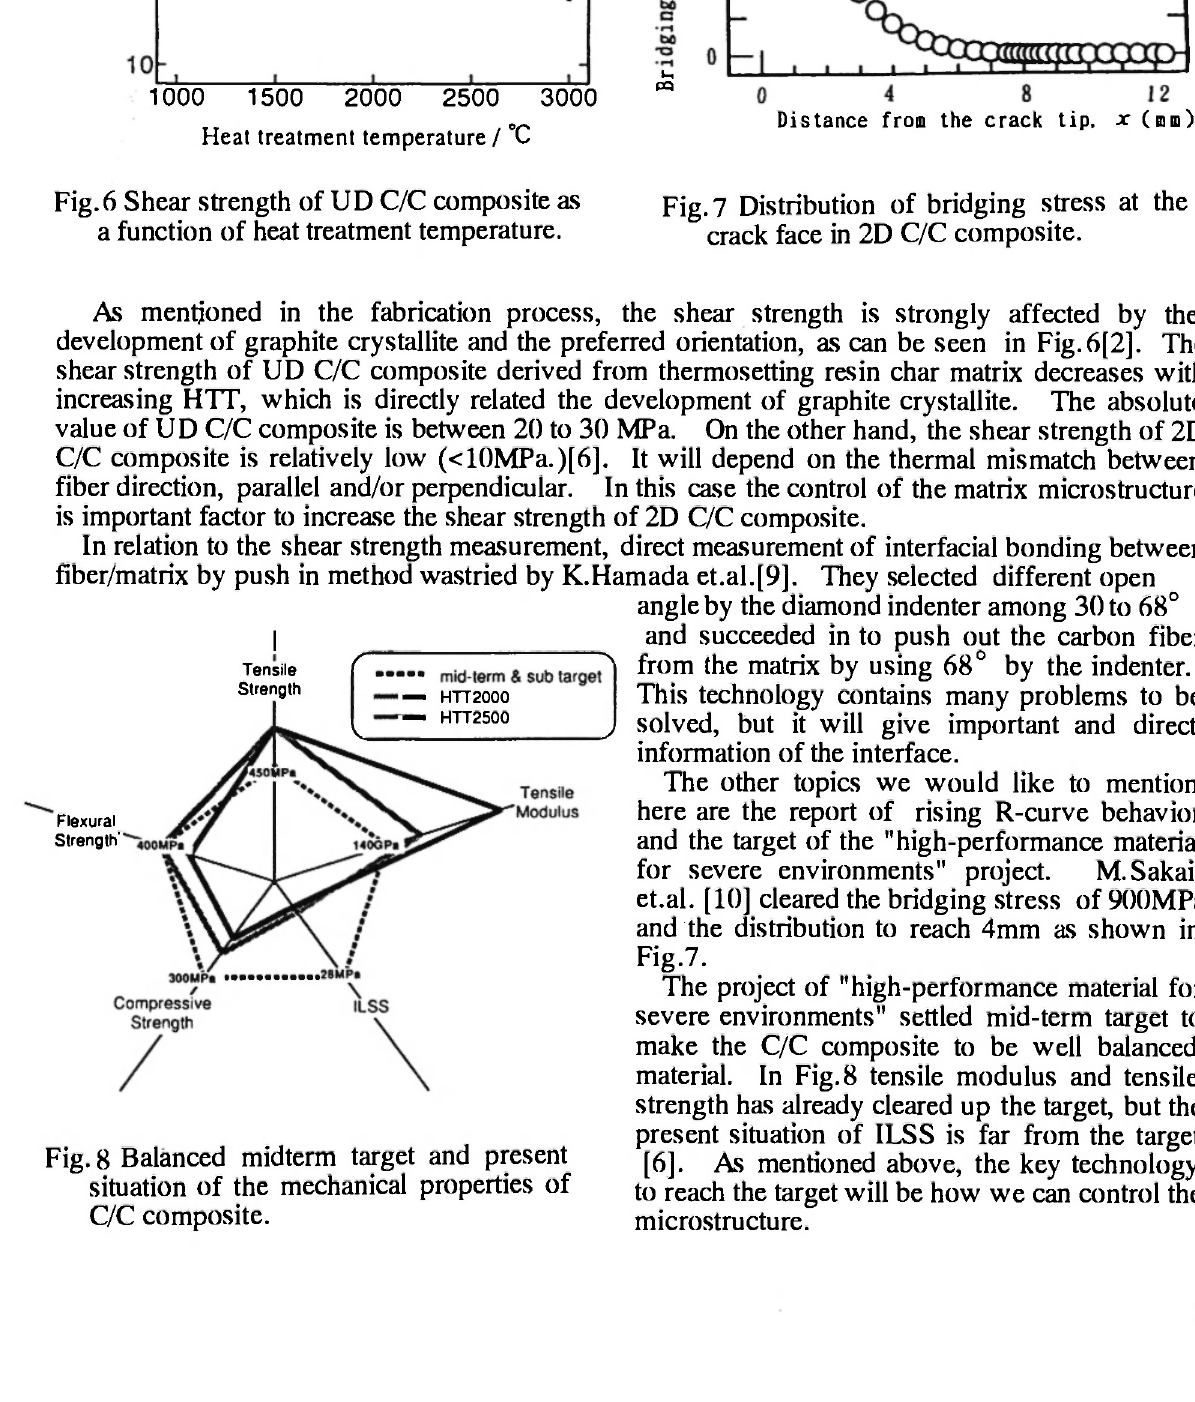
Fig. 6 Shear strength of UD C/C composite as a function of heat treatment temperature.